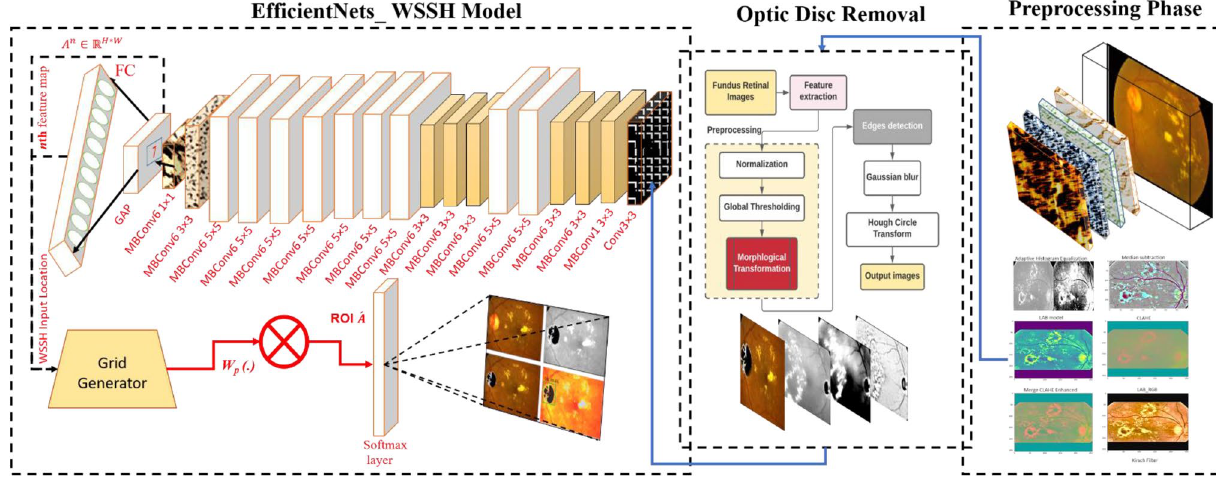
Figure 1. The schematic diagram of the proposed WSSH_DR model with multi-scale features strategy, modified preprocessing, ODR algorithm, and fully connected layer in EfficientNetB5